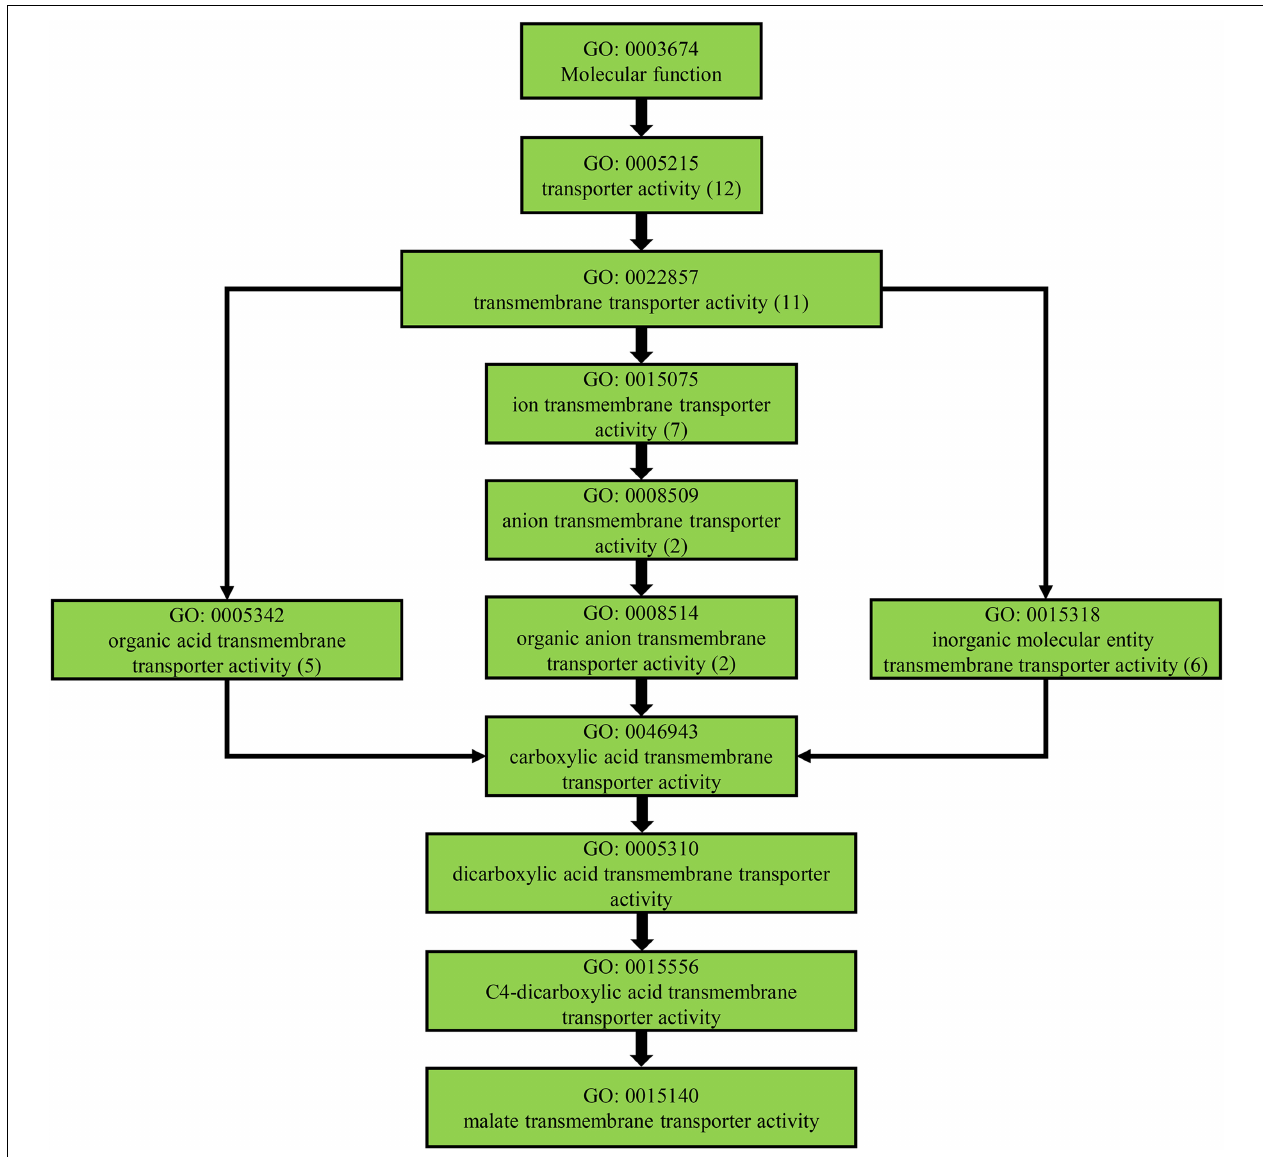
FIGURE 4 | Transmembrane transporter activity related pathway detected from the positively selected genes of Urophysa